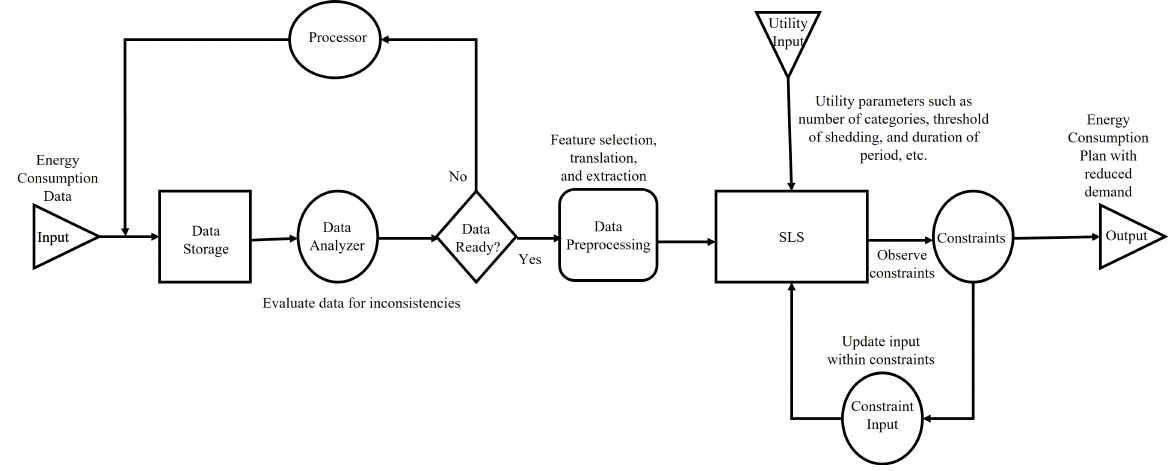
Figure 3. A flow diagram of SLS